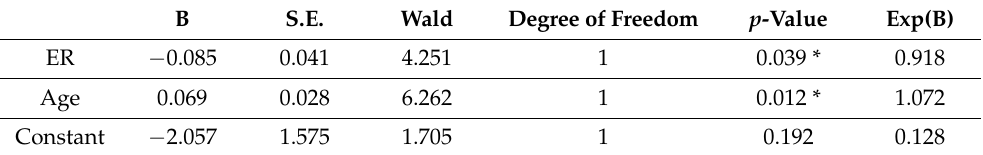
Table 7. Regression analysis between the presence of RCD and ER strength by adjusting for age. B S.E. Wald Degree of Freedom p -Value Exp(B) ER − 0.085 0.041 4.251 1 0.039 * 0.918 Age 0.069 0.028 6.262 1 0.012 * 1.072 Constant − 2.057 1.575 1.705 1 0.192